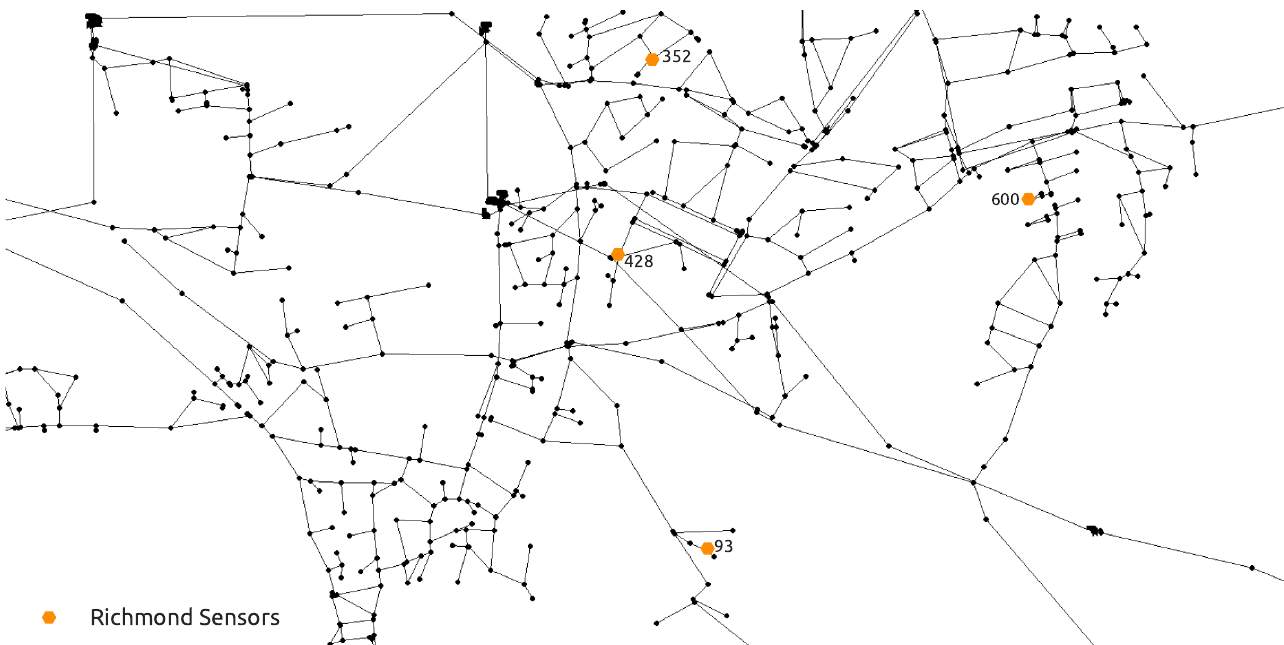
Figure 4. Richmond water distribution network benchmark detail with the positions of 4